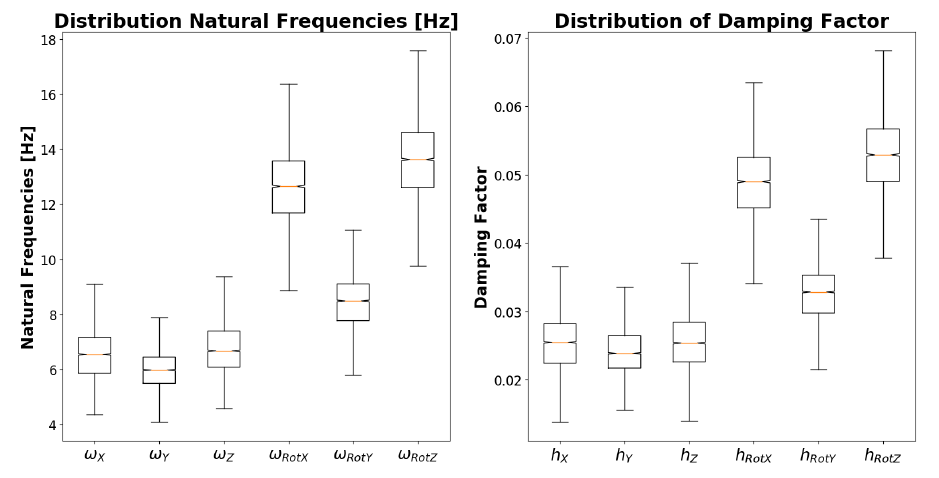
Figure 4. Range of investigated natural frequencies and damping factors.